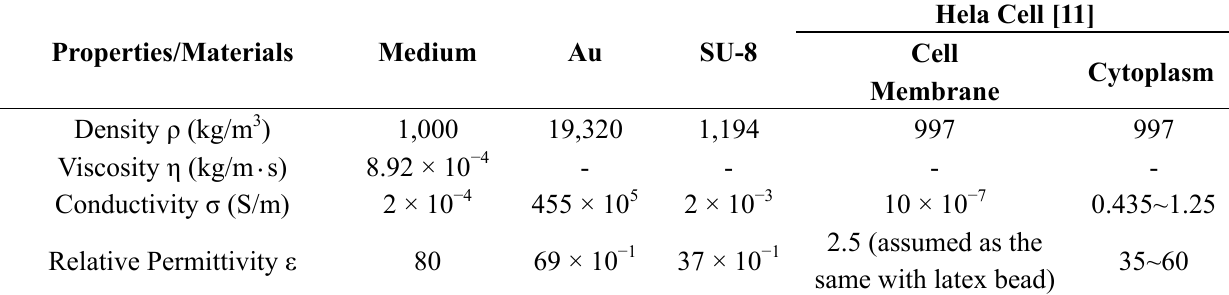
Table 1. Material Properties for